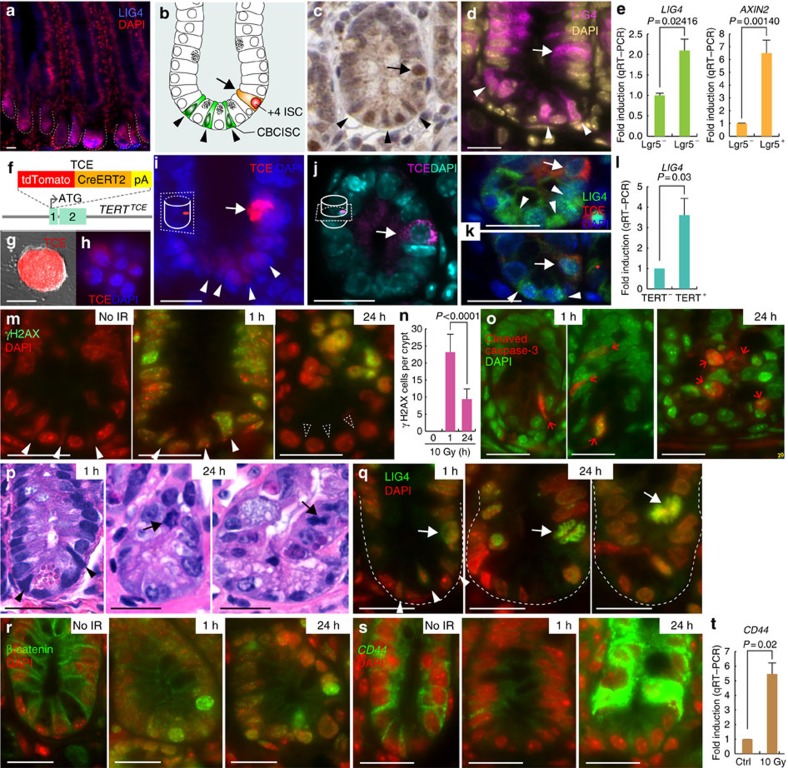
Expression of LIG4 in the intestine.(a) Expression of LIG4 in mouse small intestine samples; IF staining. Scale bars, 50μm. (b) Illustration of ISCs in the small intestine. ISCs located at position 4 (+4) are indicated by arrows, and CBC ISCs are indicated by arrowheads hereafter. (c) Expression of LIG4 in the human small intestine. 3,3′-Diaminobenzidine substrate staining. (d,e) Expression of LIG4 in the crypt of the mouse small intestine. IF staining (d) and qRT–PCR (e) of Lgr5+ and Lgr5− cells isolated from the crypts of Lgr5CreERT2 strain. AXIN2 served as a positive control for Wnt/β-catenin signalling activity. Student's t-test; N=3; error bars=±s.e.m.; scale bars=20μm. (f) Generation of the TERTTCE strain. TCE was inserted into the TERT allele-coding sequence in frame. (g,h) Expression of TCE in mouse ESCs. Low (g) and high (h) magnification. Scale bars=100μm. (i,j) TCE expression in the crypt of mouse small intestine samples (TERTTCE mouse). Sagittal (i) and transverse (j) sections. Scale bars=20μm. (k,l) Expression of LIG4 in the TCE-expressing cells in the crypt of mouse small intestine samples (TERTTCE mouse). IF staining (k) and qRT–PCR (l) of TERT+ cells isolated from TERTTCE. Student's t-test; N=3; error bars=±s.e.m.; scale bars=20μm. (m,n) WBI-induced DNA damage formation. Mice were treated with WBI (10 Gy; hereafter). Notably, CBC ISCs (arrowheads) disappeared 24 h after WBI. IF staining (m); quantification of phospho-γH2AX+ cells per crypts (the number of crypts counted ≥40) (n). Student's t-test; N=3; error bars=±s.e.m.; scale bars=20μm. (o) Apoptosis of CBC cells. Samples of mouse small intestine treated with WBI. Scale bars=20μm. (p) Mitosis of IECs after WBI. Mitotic cells (arrows); haematoxylin and eosin staining. Scale bars=20μm. (q) LIG4 upregulation in mitotic cells (arrows). CBC ISCs (arrowheads). Scale bars=20μm. (r) WBI-induced activation of β-catenin. Of note, WBI (10 Gy) rapidly induces β-catenin's localization change from the cell adhesion to the cytosol and the nucleus 1 and 24 h after WBI. Scale bars=20μm. (s,t) CD44, a β-catenin target gene, upregulation by WBI. One hour after WBI, CD44 expression is diffused. Twenty-four hours after WBI, CD44 expression is considerably upregulated in IECs at transit-amplifying zone but not in Paneth cells. IF staining (s); qRT–PCR of crypts (10 Gy, 24 h). Student's t-test; N=3; error bars=±s.e.m.; scale bars=20μm. For comparative analysis, images for each figure were captured under the same exposure time. DAPI, 4,6-diamidino-2-phenylindole.